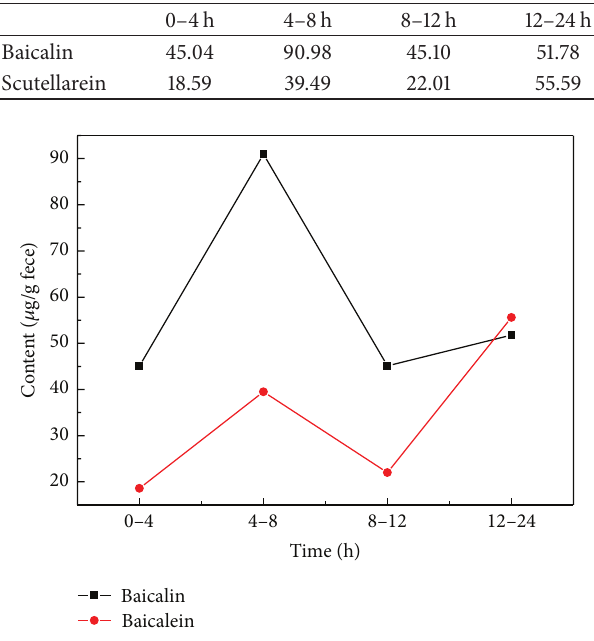
Figure 6: Baicalin and baicalein content at each time phase diagram in fecal content.